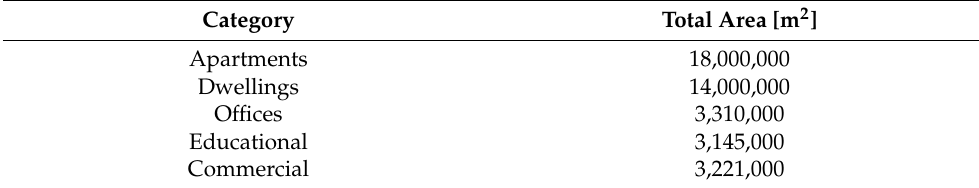
Table 11. Renovation volume for Estonian buildings by